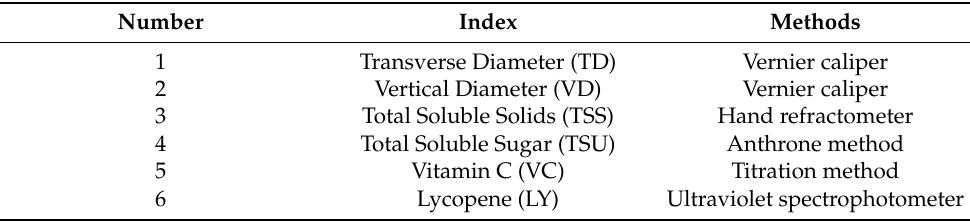
Table 3. Measurement